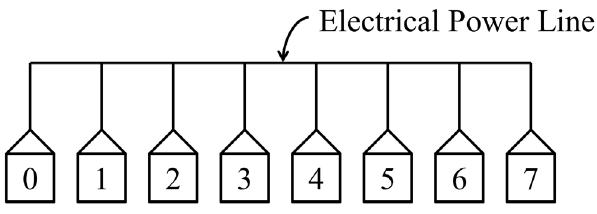
Figure 2. Example of a one-dimensional grid: a chain network. This example has a network of size N=